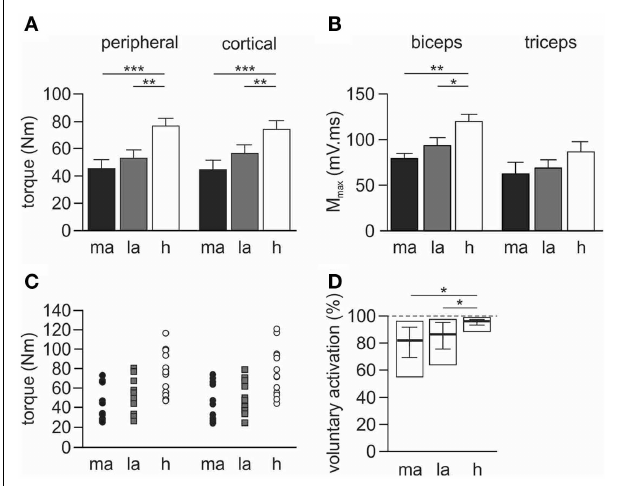
FIGURE 2 | Maximal torque, M max and voluntary activation during peripheral nerve stimulation . Data for torque and M max are presented as mean ± SEM, and voluntary activation as median and interquartile range. (A) Maximal voluntary torque (Newton meter) generated during the 100% MVC for both peripheral and cortical stimulation protocols. (B) Maximal compound muscle action potential (M max ) evoked in the resting muscles during stimulation at Erb’s point. Results are shown for the biceps and triceps muscles. (C) Individual maximal voluntary torque data for both peripheral (circles) and cortical (squares) stimulation protocols. (D) Pooled voluntary activation scores calculated from peripheral nerve stimulation. The open rectangle represents the maximum and minimum scores for each group calculated from the mean of the five trials.The solid horizontal line is the median score with the interquartile range.The dashed line represents the highest possible score at 100% voluntary activation. ma, More-affected side, la, less-affected side, h, healthy subjects. * p < 0.05, ** p < 0.01, *** p <